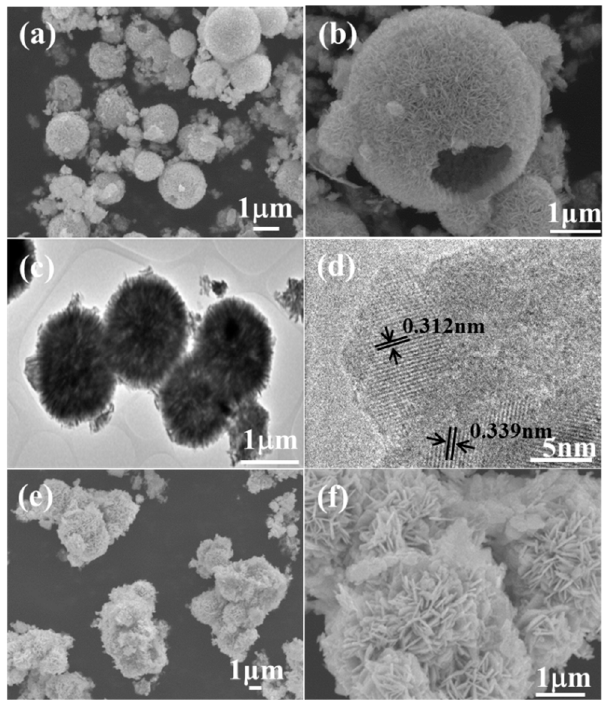
Figure 4. ( a , b ) SEM image of Bi 3 O 5 I 2 ; ( c , d ) TEM image of Bi 3 O 5 I 2 ; ( e , f ) SEM image of BiOI.